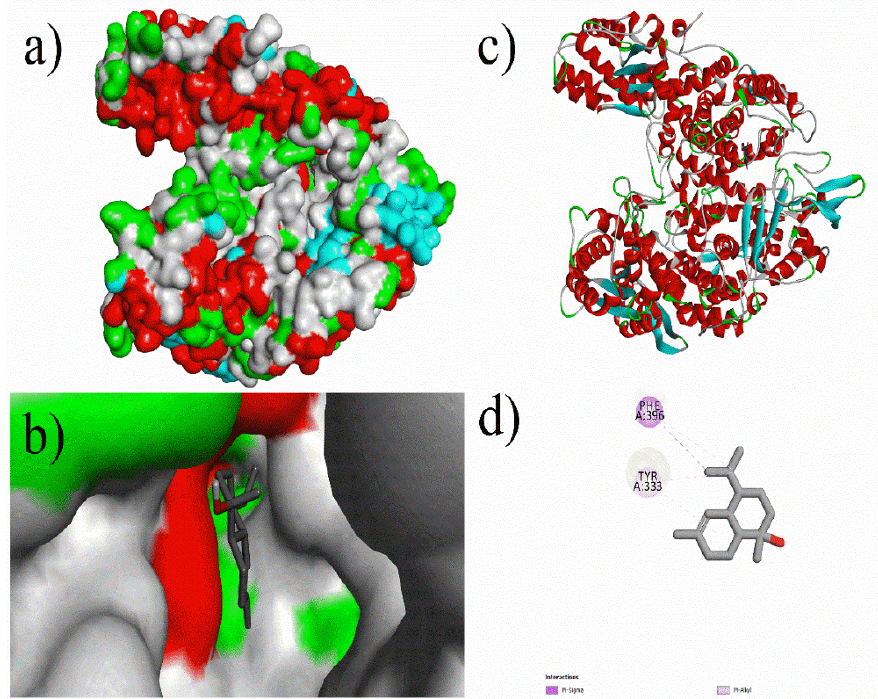
Figure 4. Molecular docking of α -cadinol with 5A8K protein: ( a ) Docking surface pocket pose, ( b ) docking interaction at surface, ( c ) 3D protein–ligand interaction, and ( d ) 3D interaction of protein amino acid residues with compound α -cadinol.